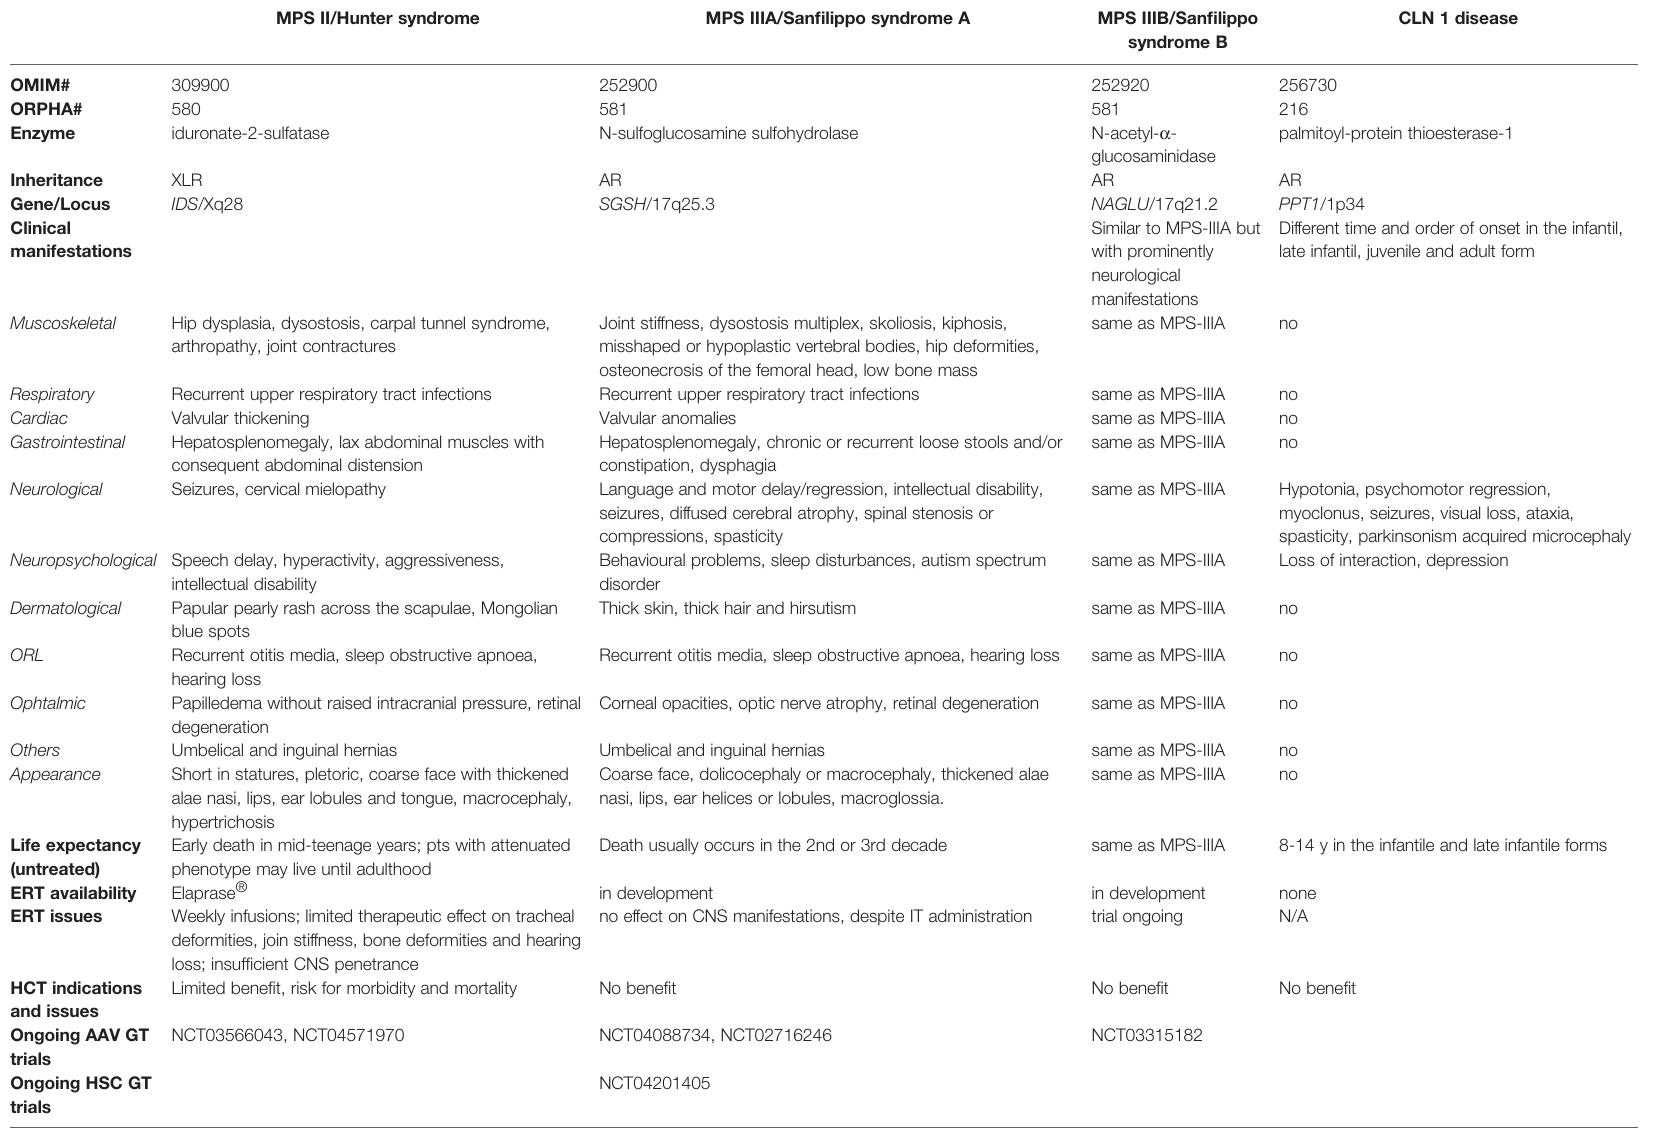
TABLE 1 | Clinical manifestation and available treatments for selected